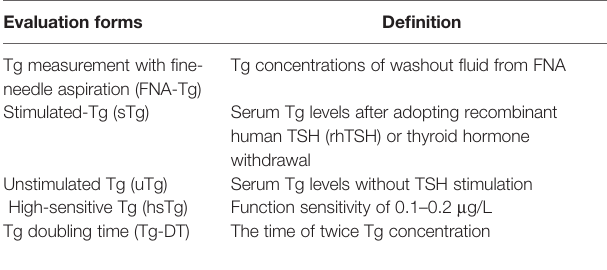
TABLE 1 | Evaluation forms of thyroglobulin in the monitoring of differentiated thyroid